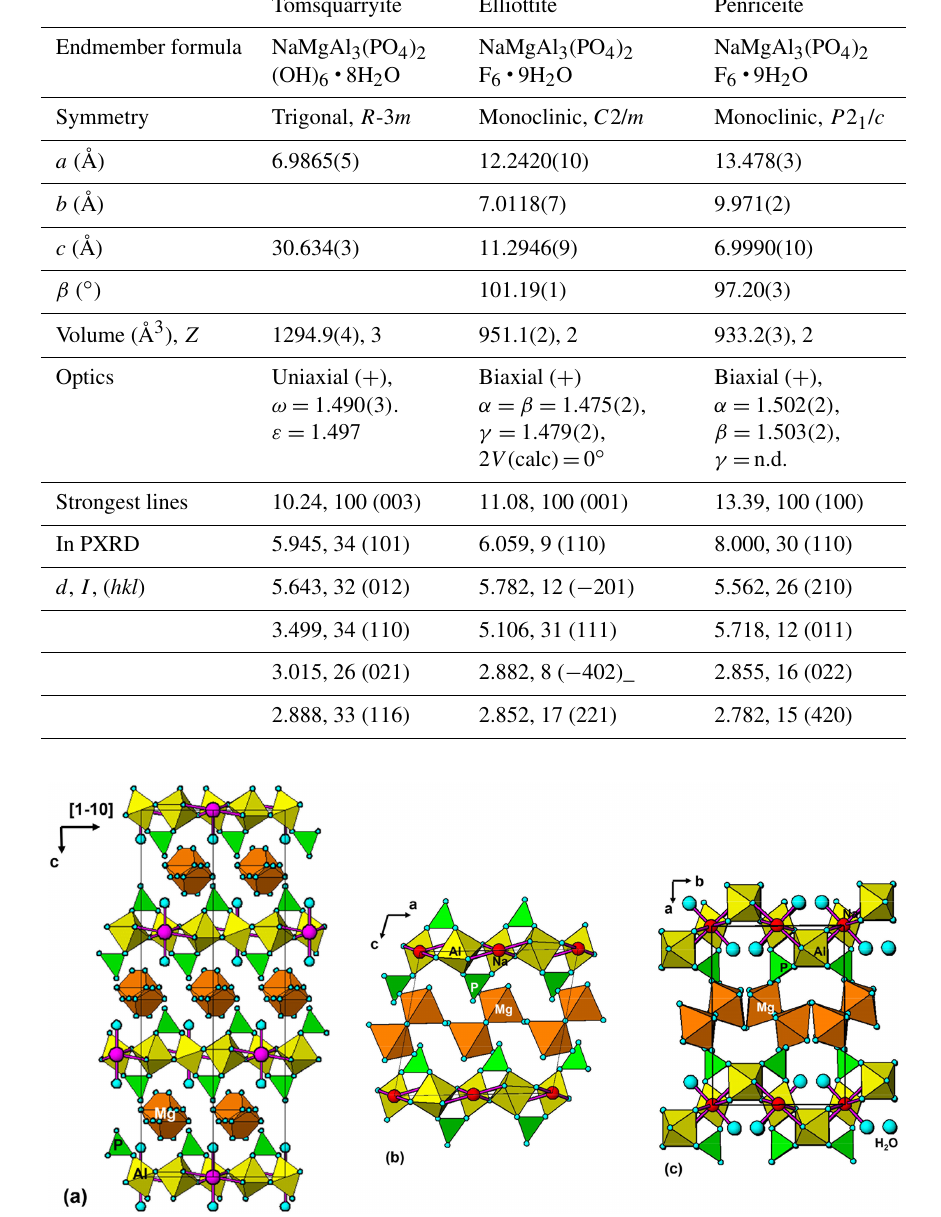
Figure 6. (a) Projection of tomsquarryite structure along [110]. (b) [010] projection of the structure of elliottite. (c) [001] projection of the structure of